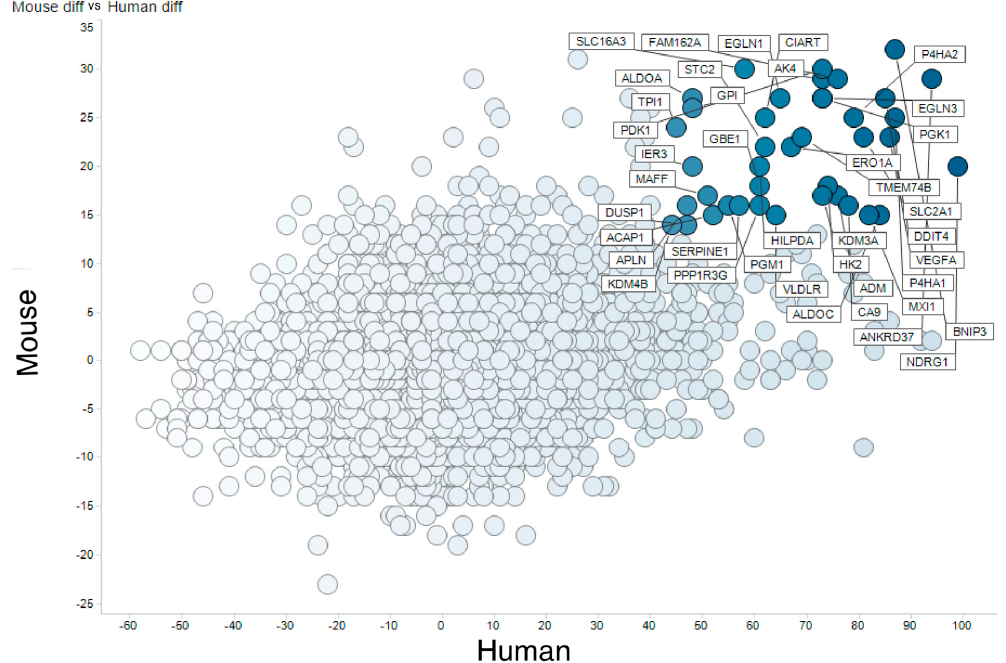
Figure 2. Meta-analysis of hypoxic transcriptomes by RNA-seq. Comparison of human and mouse hypoxic transcriptomes analyzed by RNA-seq. The X axis shows (count of human RNA-seq UP) − (count of human RNA-seq DOWN) and the Y axis shows (count of mouse RNA-seq UP) − (count of mouse RNA-seq DOWN).